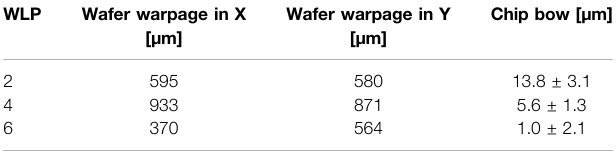
TABLE 3 | Warpage of the WLP 2, 4 and 6 and bow of their